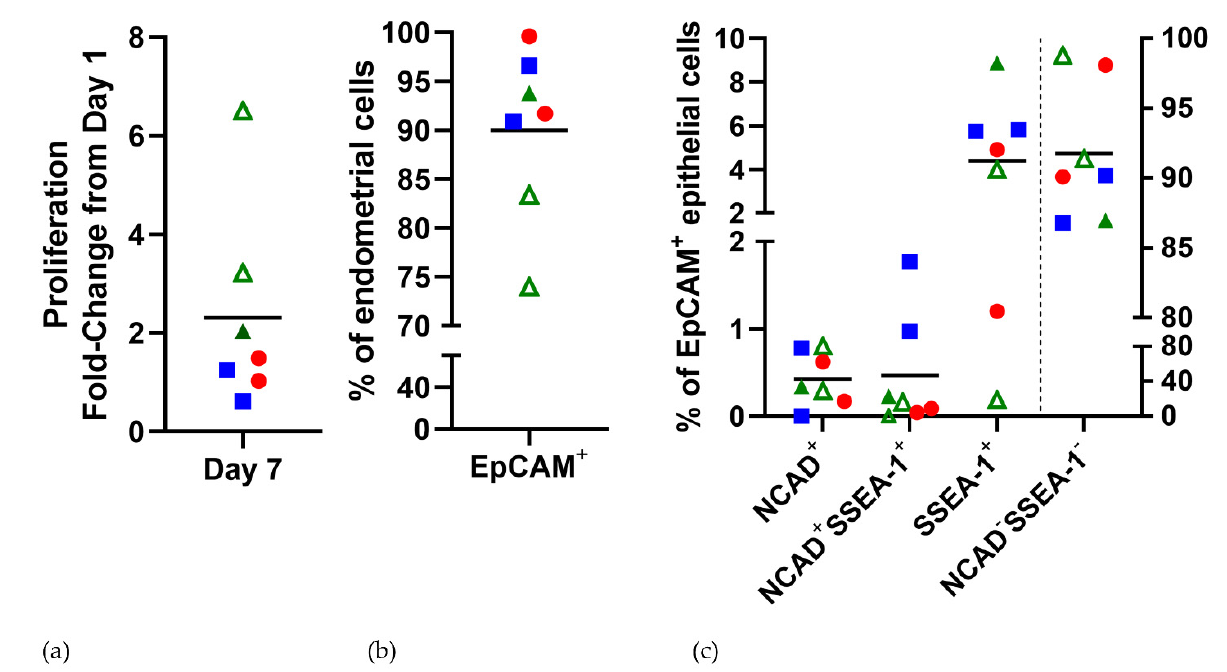
Figure 2. MFO and EMO-H show similar proliferation rates ( a ) and cell surface marker expression ( b , c ) to EMO. Proliferation rates are expressed as the fold changes on day 1. (cid:4) EMO; • MFO; green triangles EMO − H; open EMO − OCP; closed EMO-Mirena ® ).